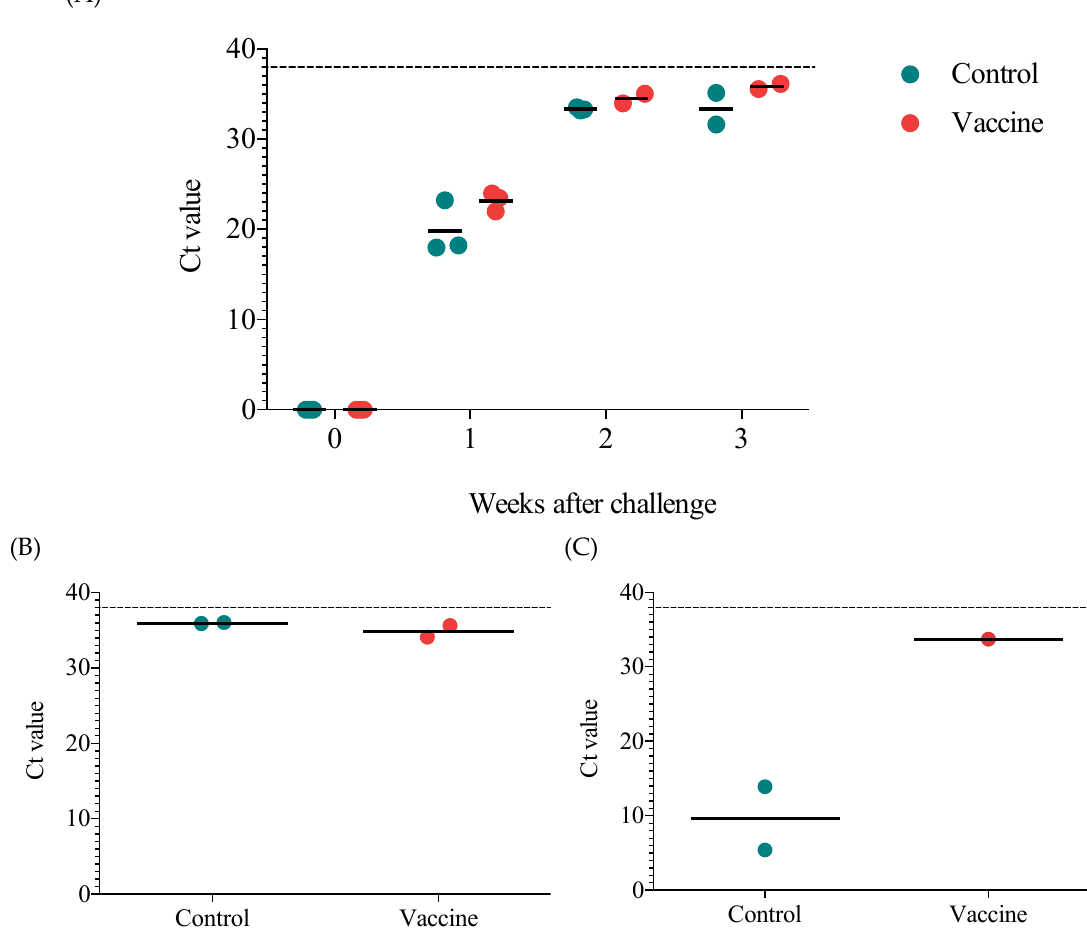
Figure 5. Viremia and the viral load in the lungs and tonsils of challenged pigs. ( A ) Viremia evaluated on the day of the challenge and every week thereafter until the end of the experiment (three weeks postchallenge). The viral load in the lungs ( B ) and tonsils ( C ) at the end of the experiment. The results are expressed as cycle threshold ( Ct ) values, and the dotted line represents the cut-off for qPCR. Each point represents the Ct value of one pig.